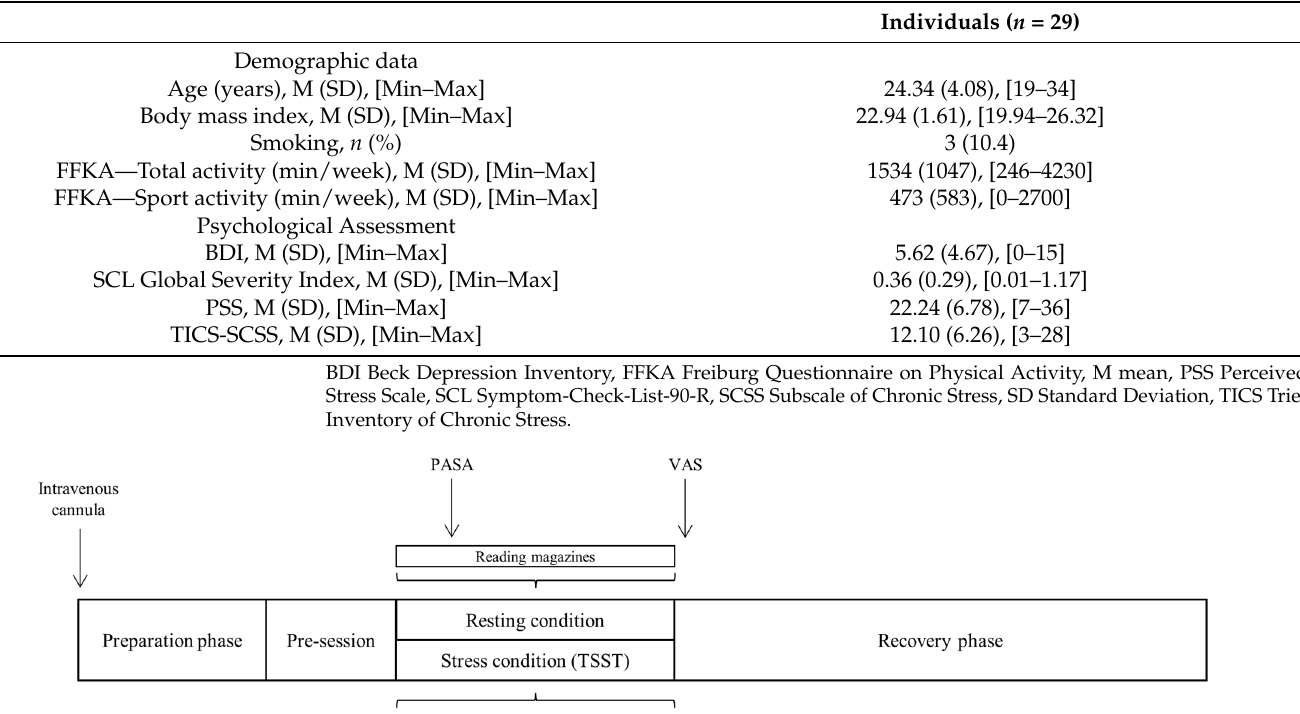
Table 1. Characteristics of the male participants.